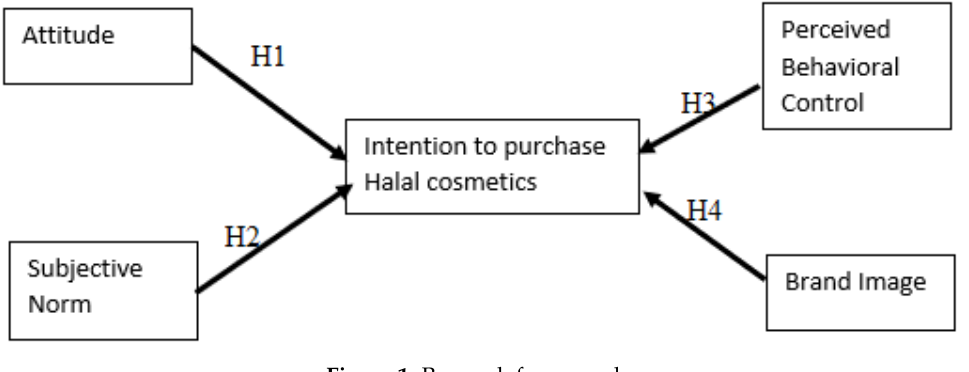
Figure 1. Research Figure 1. Research framework.